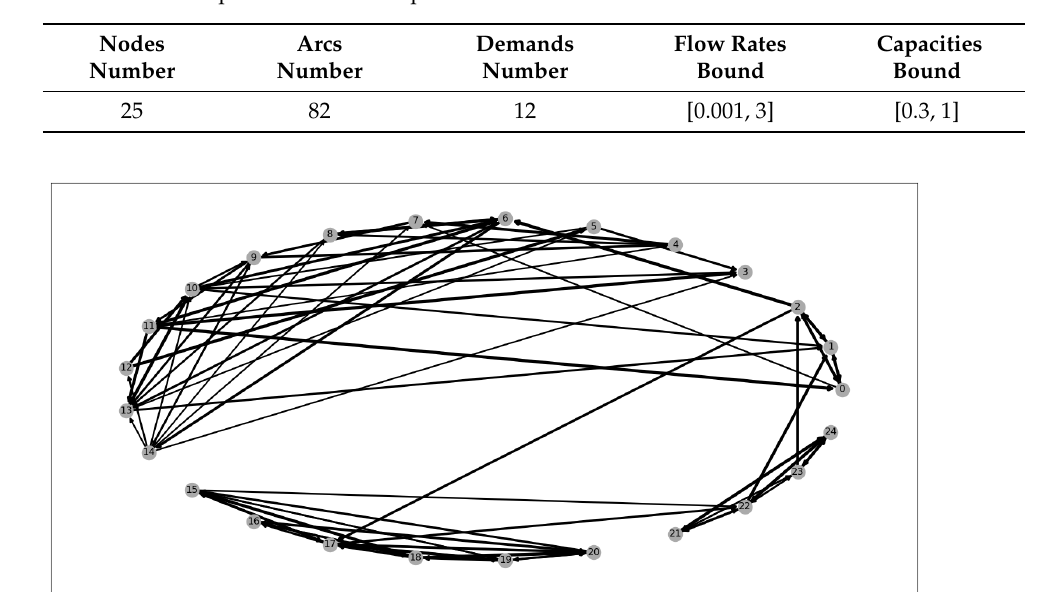
Figure 1. Medium network